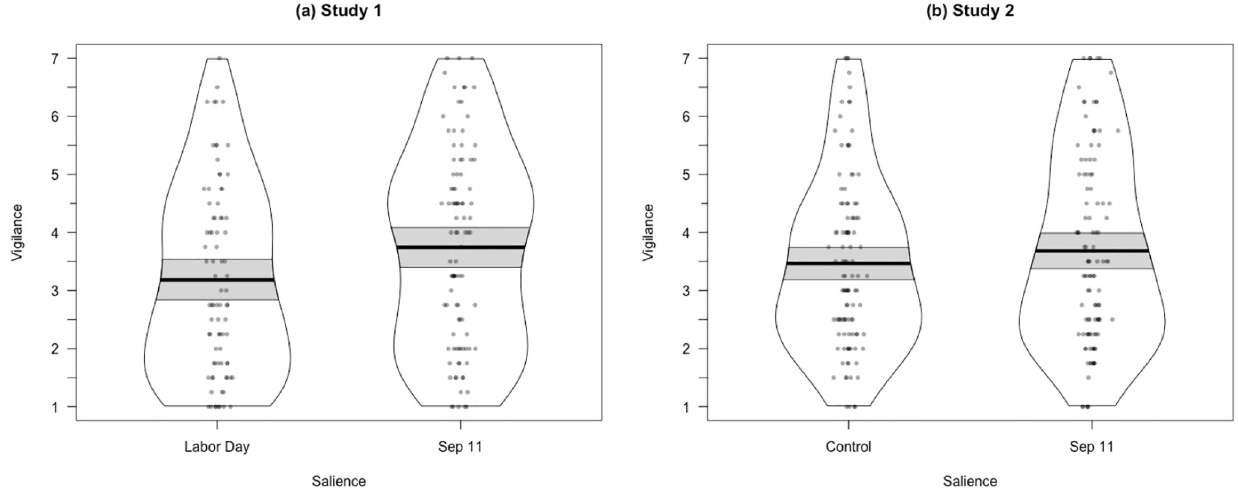
bars represent unadjusted means. Shaded bands represent 95% confidence